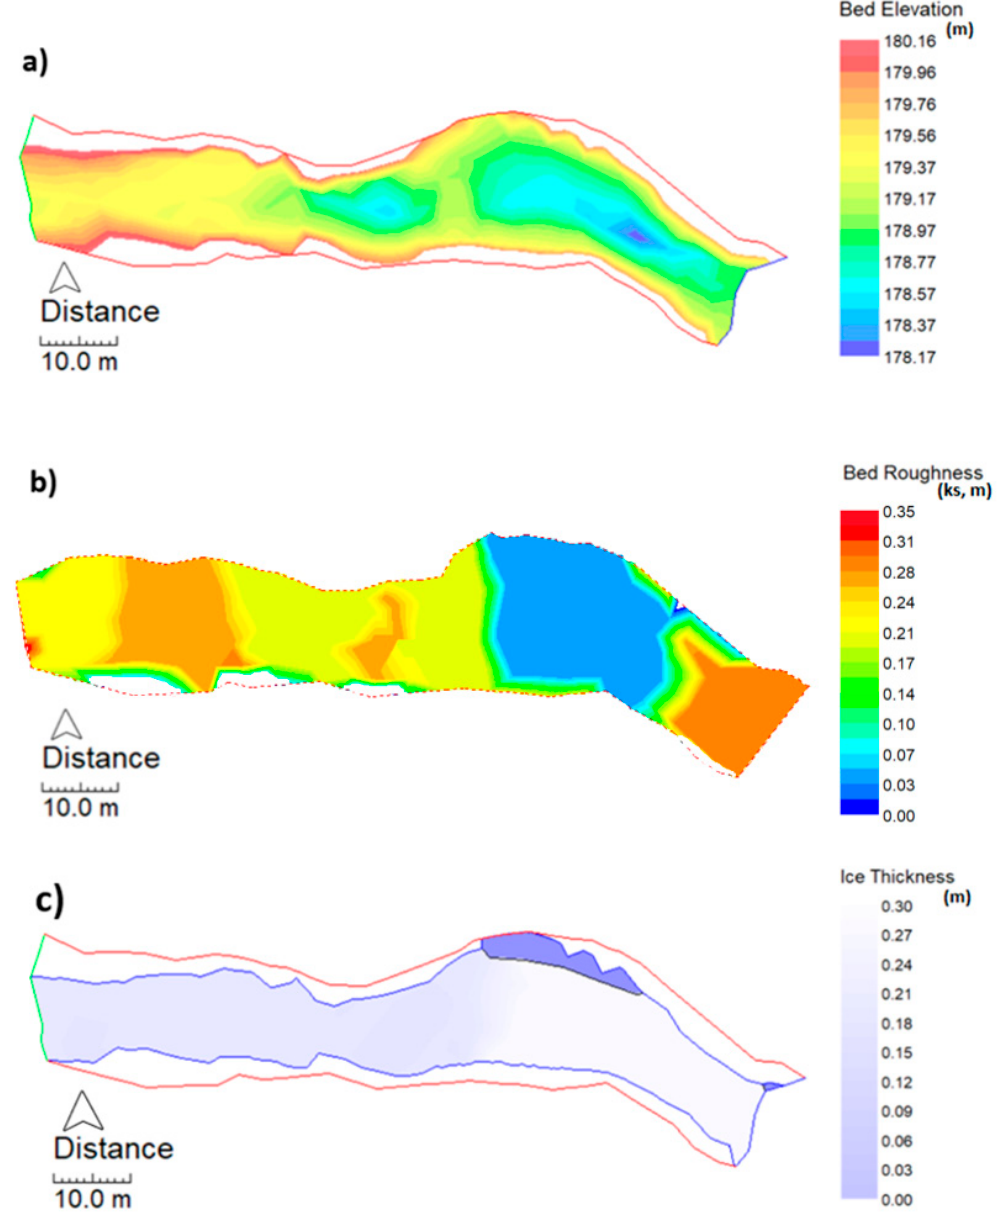
Figure 2. Interpolated model surfaces. ( a ) Channel bed elevation, ( b ) channel bed roughness, and ( c ) ice thickness (dark colors represent minimal (or no) ice thickness). Bed roughness was manually prepared in the River2D_bed extension and extends past water edge to ensure roughness val-